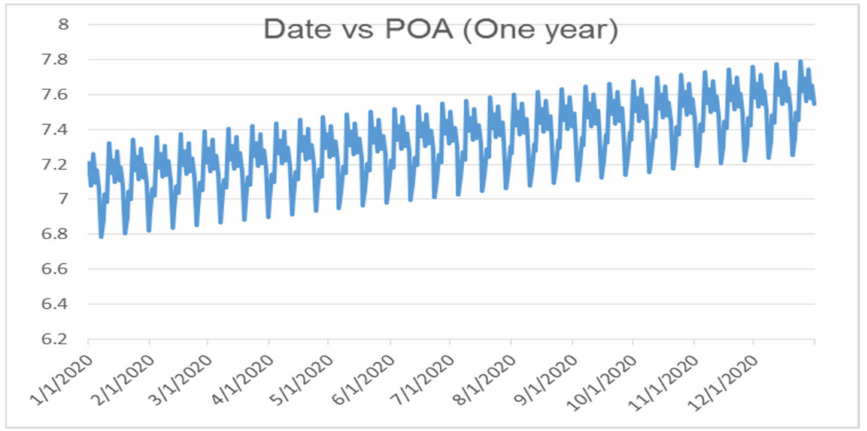
Figure 10. One-yearpredictionresultsoftheplaneofarray(POA)from1January2020to1 December 2020.